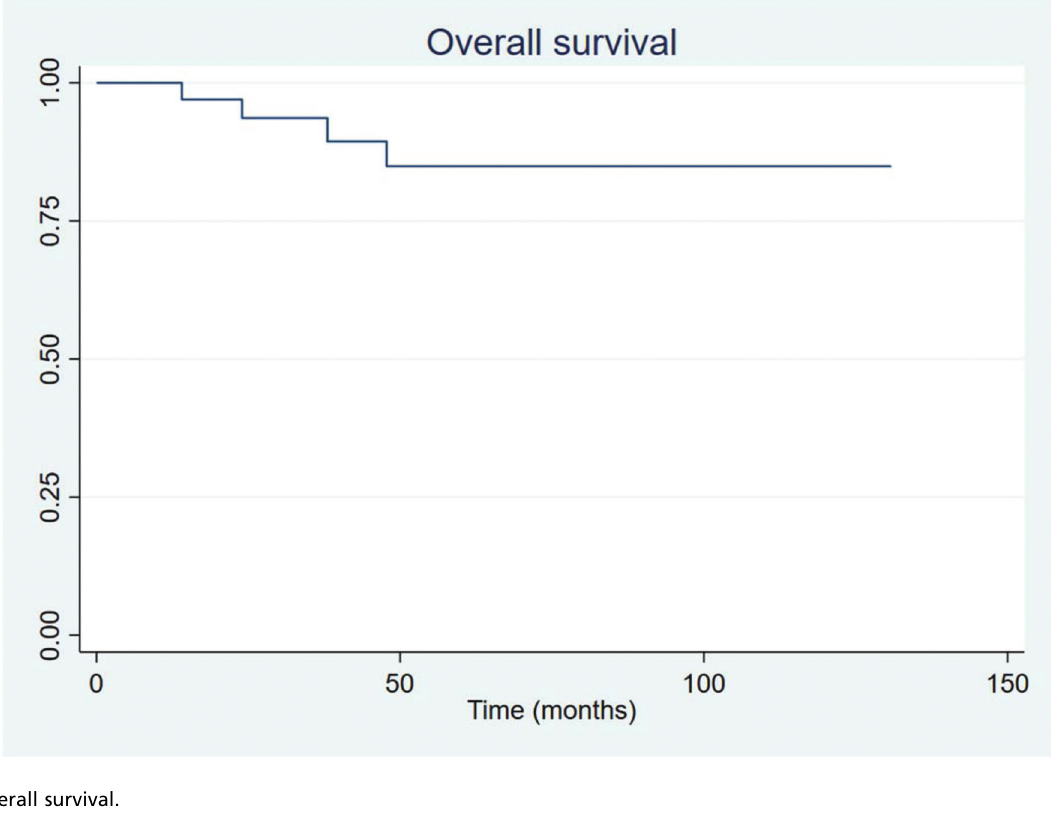
Fig 1 - Overall survival.